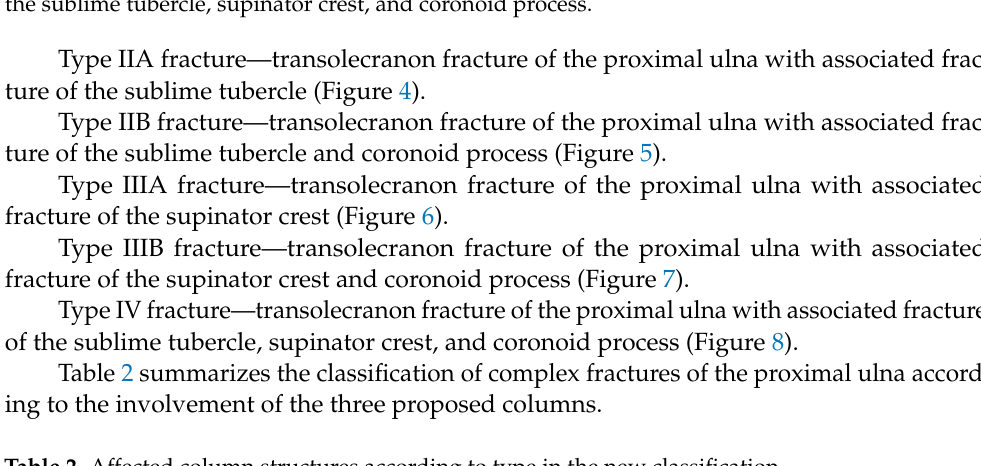
Table 2. Affected column structures according to type in the new classification.